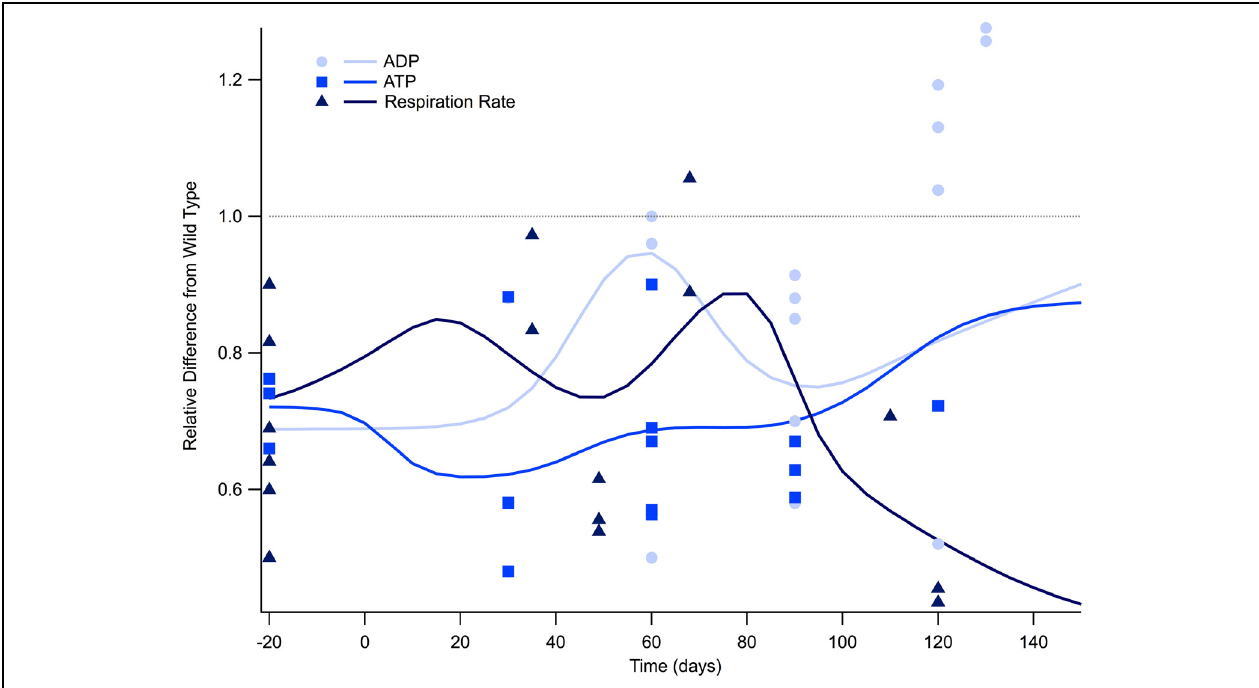
FIGURE 1 | Cellular respiration is depressed for the lifespan of the SOD1 G93A transgenic mouse model. The ratio of SOD1 G93A to wild type (SOD1 G93A/wild type) is plotted over time for experimental measures of adenosine triphosphate (ATP), adenosine diphosphate (ADP), and general respiration rate. Solid lines illustrate predicted trend lines. For visualization